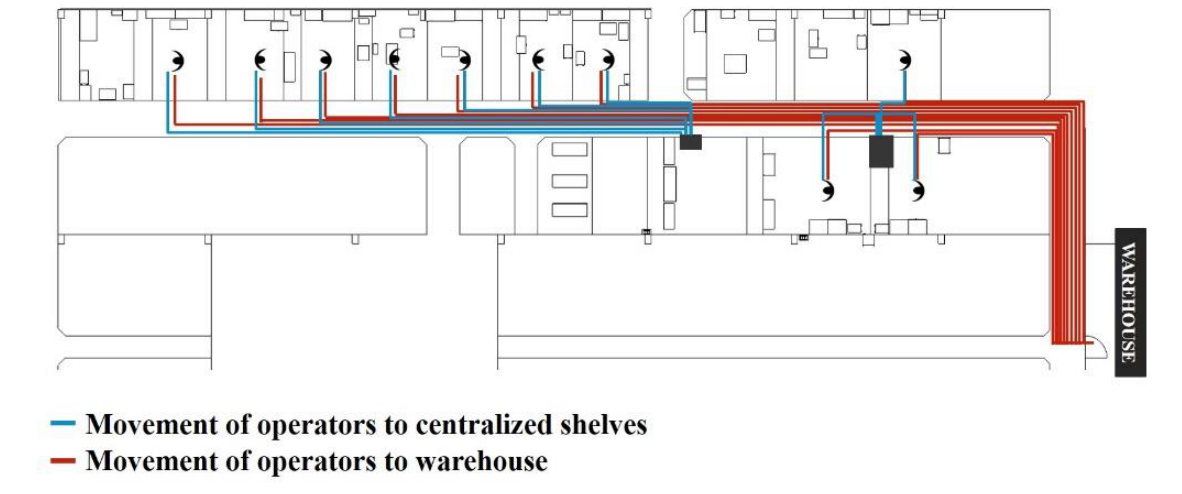
Figure 4. Spaghetti diagram representing the movements of the operators between the workstations and the central